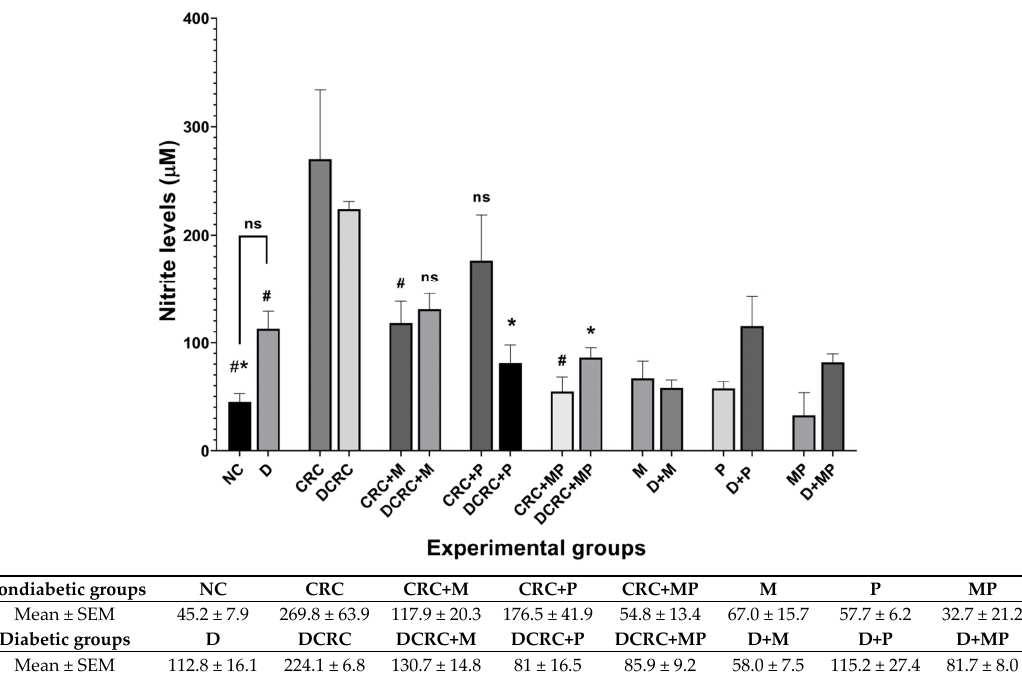
Figure 10. Nitrite modulation by metformin and probiotics. Results are expressed as mean ± SEM ( n = 4). Nondiabetic groups were compared to their experimental CRC control (CRC), significance was expressed by # p < 0.05. On the other hand, diabetic groups were compared to their experimental diabetic CRC control (DCRC); significance was expressed by * p < 0.05; ns stands for nonsignificant.